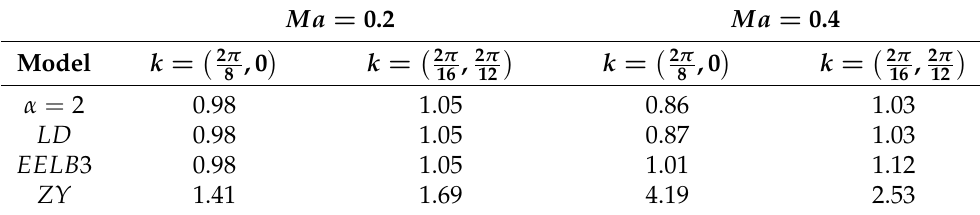
Table 3. Acoustic waves, the ratios ν e / ν ( ν e is the viscosity measured during the numerical simu- lations, ν is the theoretical viscosity) are presented. α = 2 is the standard LB method; LD is the low-dissipative entropic method described in Proposition 1; EELB 3 is the third-order EELB method; ZY is the method of Zhao and